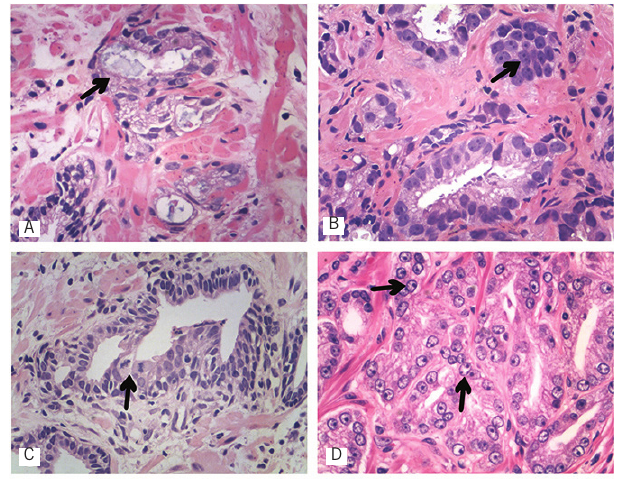
figurE − Illustrative images of some morphological criteria for the diagnosis of prostate cancer A) blue mucin (arrow) in acinar adenocarcinoma (HE, 200×); B) multiple nucleoli (arrow) in acinar adenocarcinoma (HE, 400×); C) two mitoses (arrow) in reactive epithelium (HE, 200×); D) double and marginated nucleoli (arrows) in acinar adenocarcinoma (HE, 400×). HE: hematoxylin and